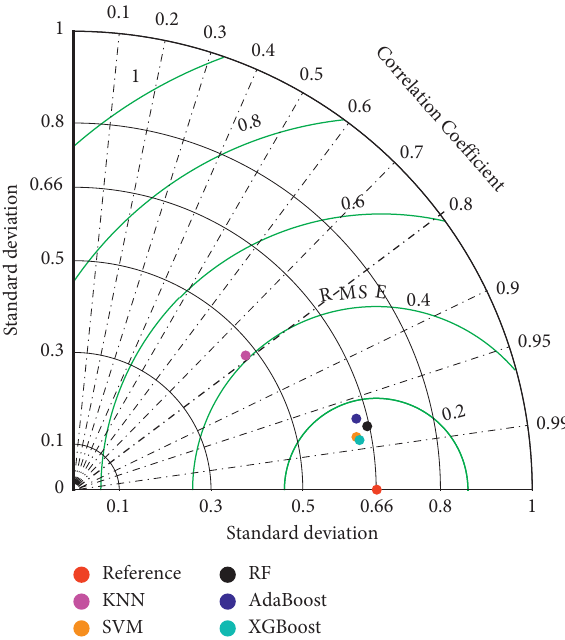
Figure 6: Taylor diagram of the